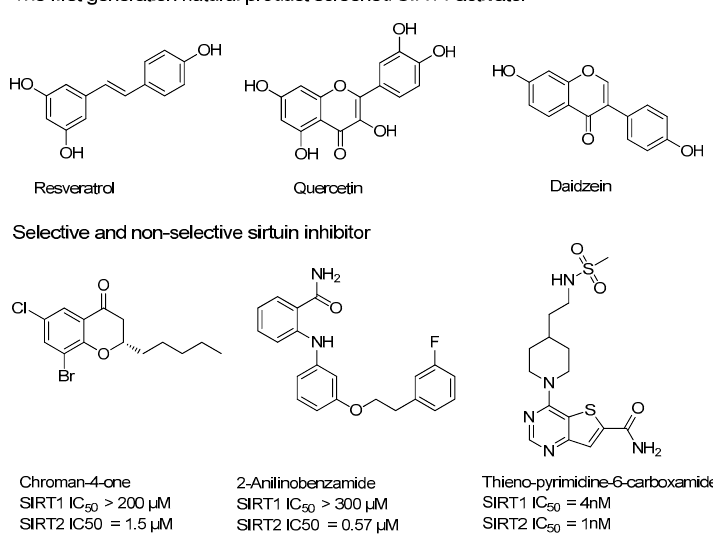
Figure 3. The structures of selected SIRT1 activators and SIRT1/2 inhibitors. The first generation SIRT1 activators were discovered from screens of flavonoids natural products. Resveratrol is one of the most potent SIRT1 activators discovered so far, while flavones (quercetin) and isoflavones (daidzein) were also found with SIRT1 activation activity. For sirtuin inhibitors, many synthesized compounds were reported with selective or non-selective sirtuin inhibitory activities.